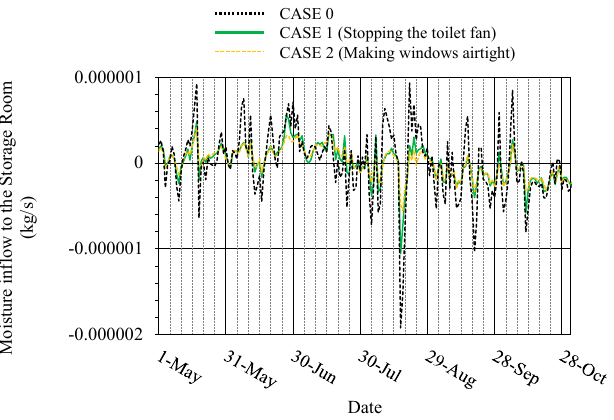
Figure 13. Mass flow rates of air through the window gaps (path 15) in CASES 0, 1, and 2.